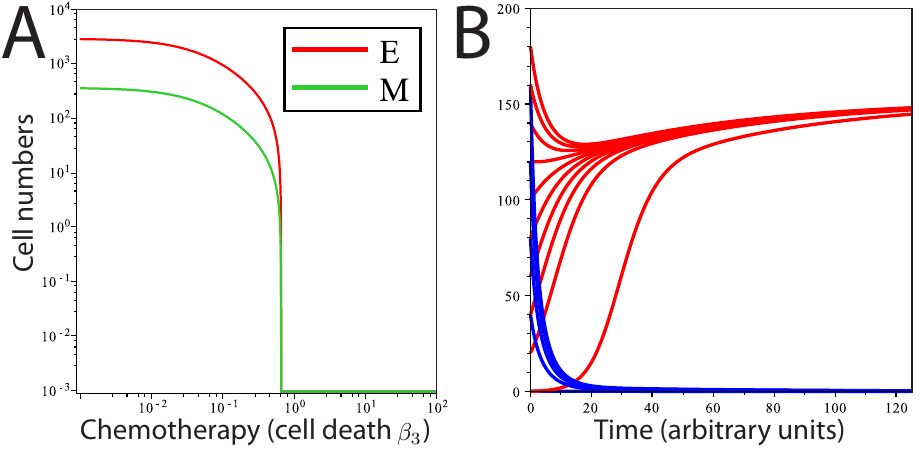
is varied; 3 < β ∗ ; blue curves 3